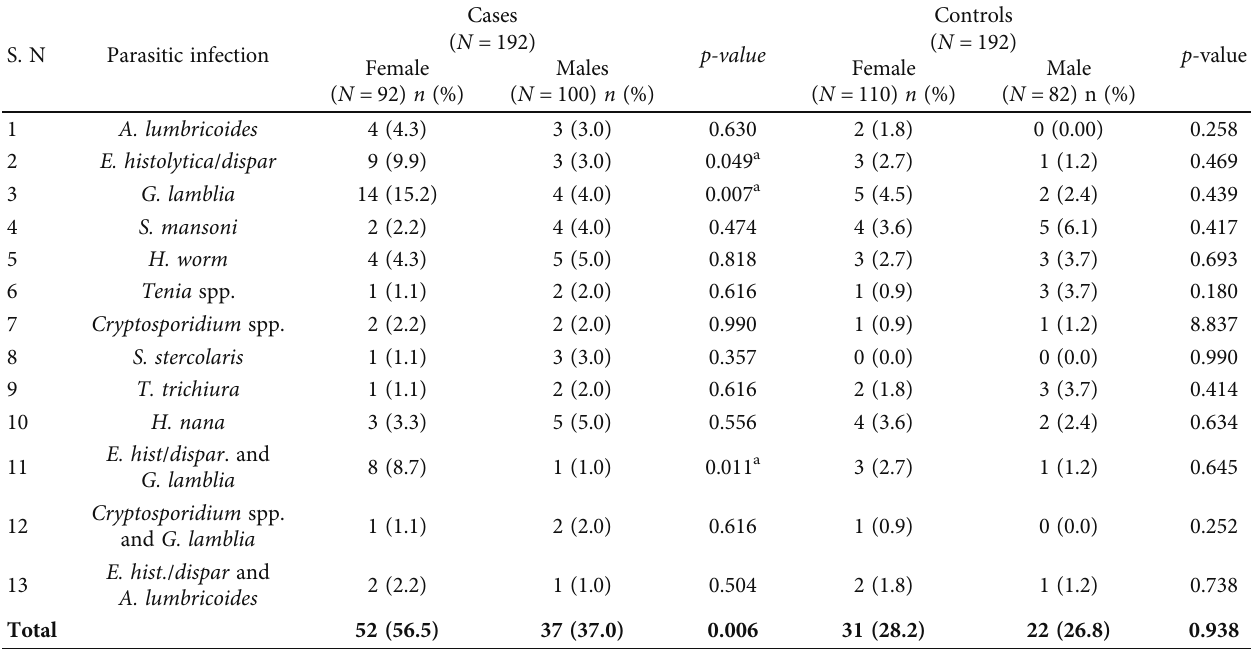
Table 4: Prevalence of intestinal protozoal parasites based on sex among diarrheal patients (cases and controls) visiting Negelle Borena General